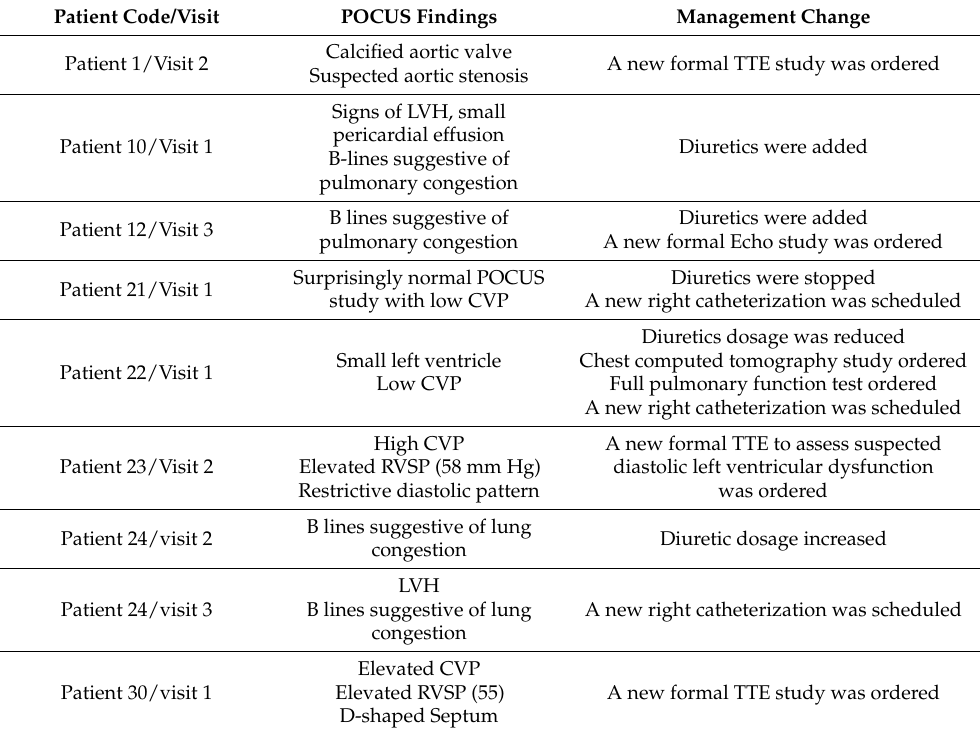
Table 5. Selected examples of management changes following POCUS